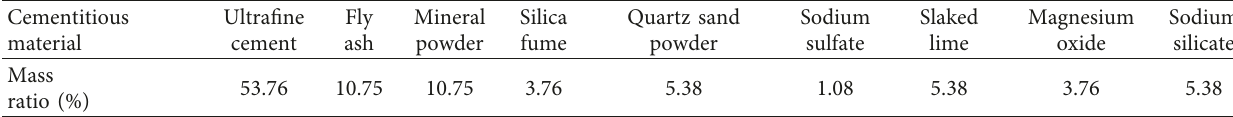
Table 1: Composition of composite substrate cementing material.